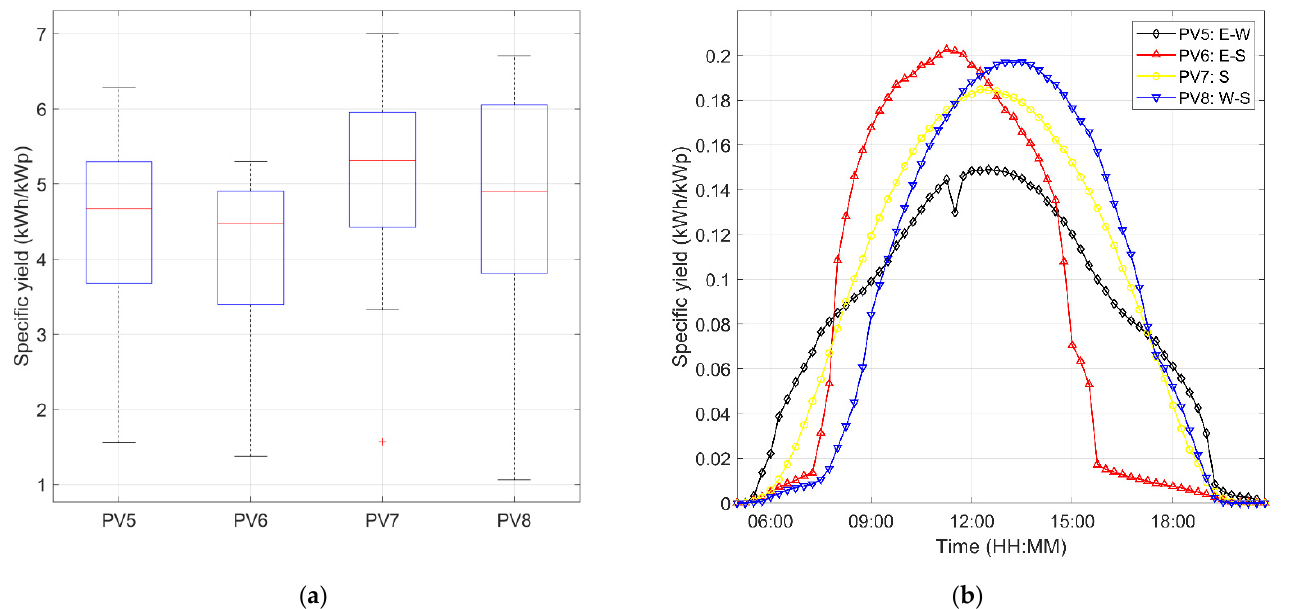
Figure 6. ( a ) Daily specific yields of the PV5–PV8 systems obtained in July 2021 and ( b ) daily energy profiles of the PV5–PV8 systems measured under a clear sky in August 2021.